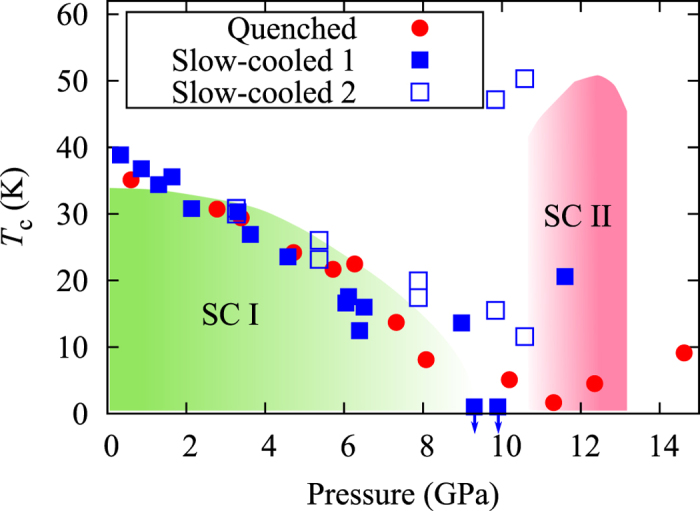
A P-T phase diagram of KxFe2−ySe230.Red circles and blue squares indicate quenched sample and slow-cooled sample, respectively. Colouring region is based on the data taken from the ref. 19.